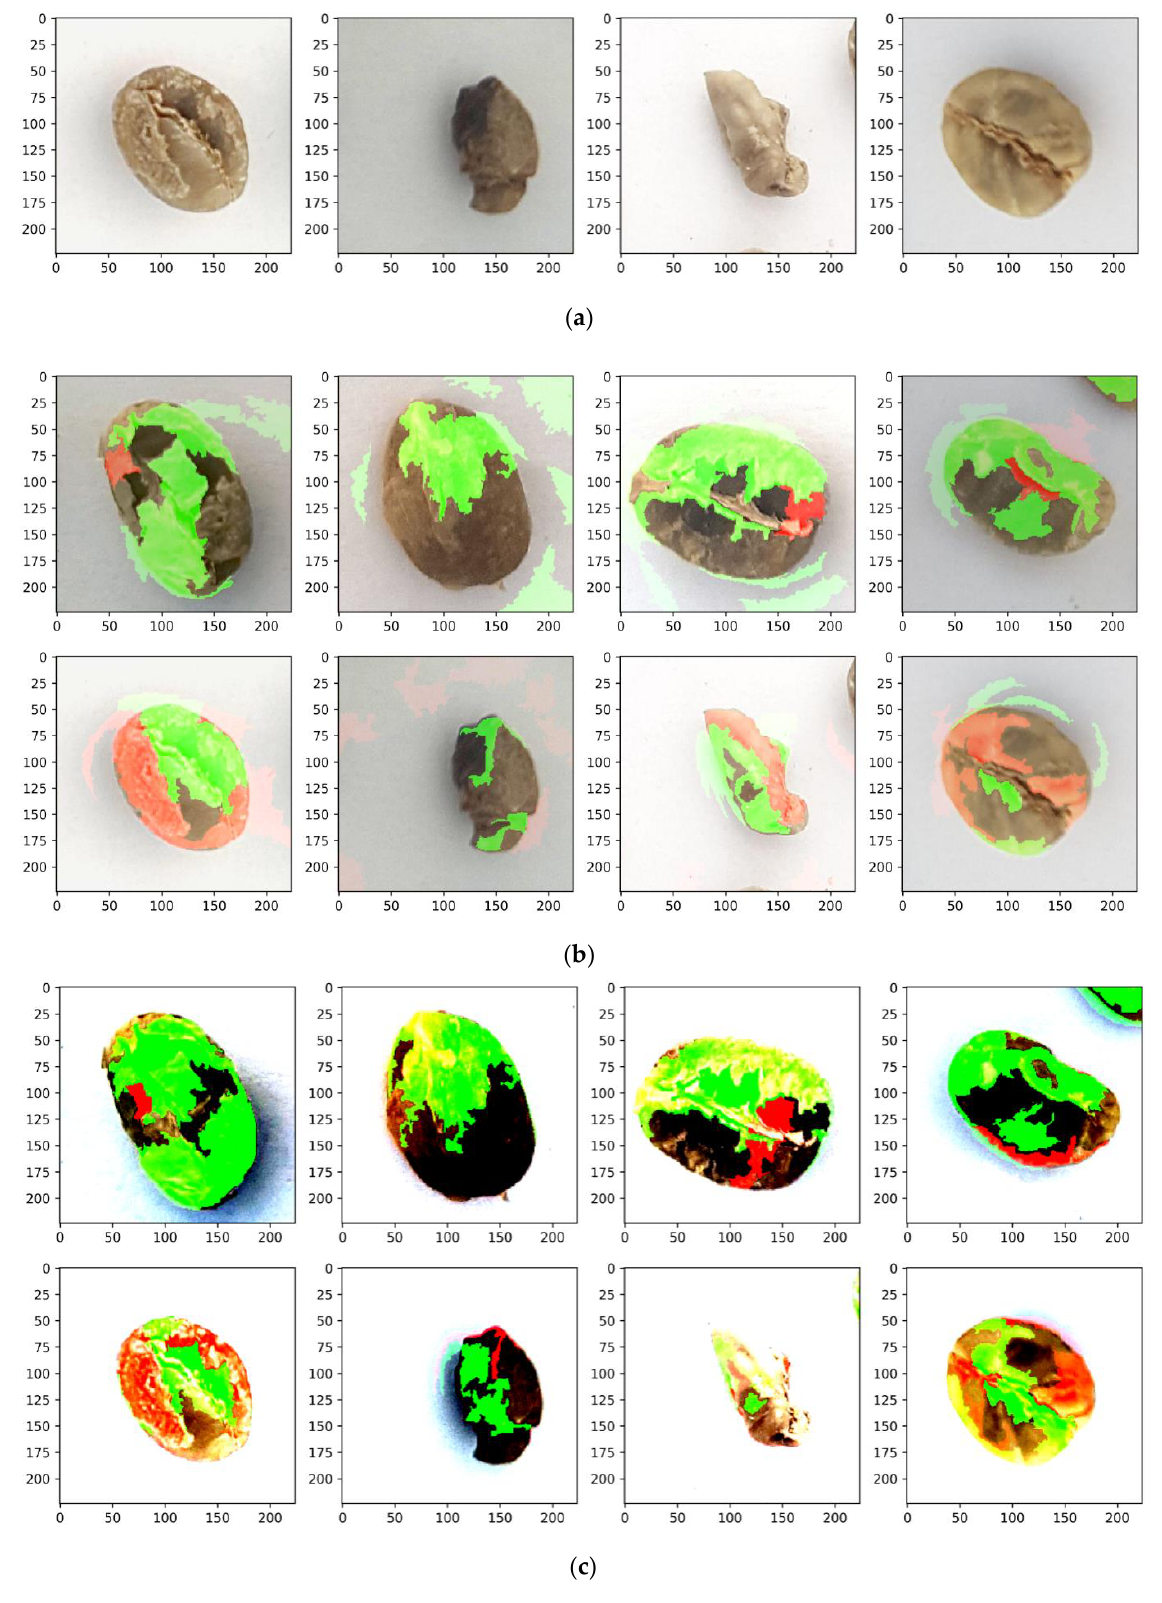
Figure 15. Results of LIME: ( a ) original green coffee beans, ( b ) without image normalization, ( c ) with image normalization.